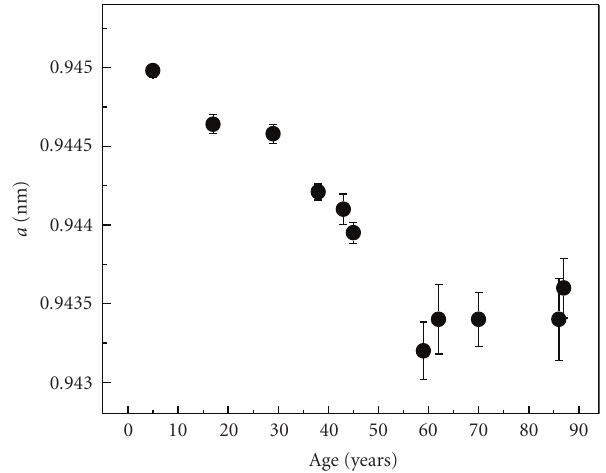
Figure 4: The a-lattice constant of the HAp phase as a function of age. Notice the increase of the error in poorly crystallized dental apatite (older-age